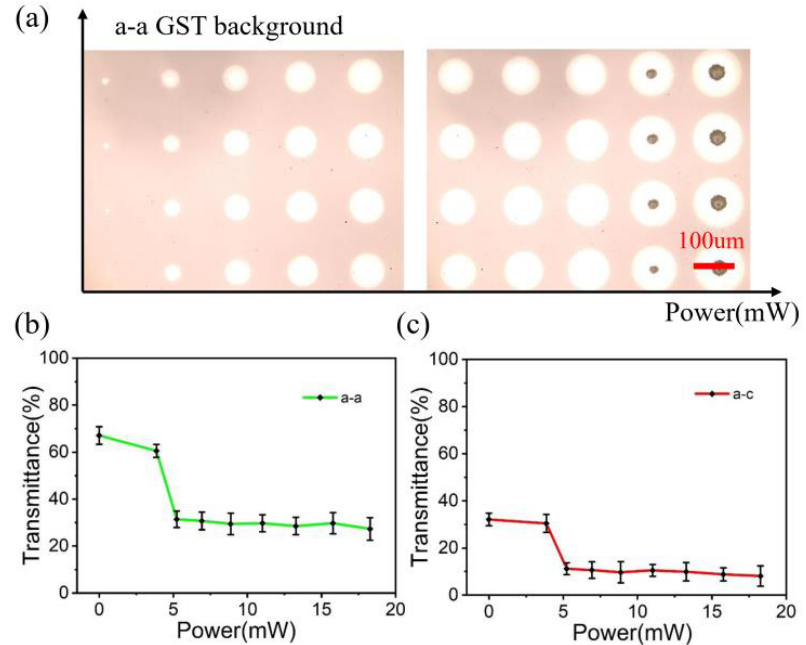
Figure 6. ( a ) Morphology of laser-induced GST phase transition in a-a background. ( b , c ) Changes of transmittance with laser power in a-a and a-c background.